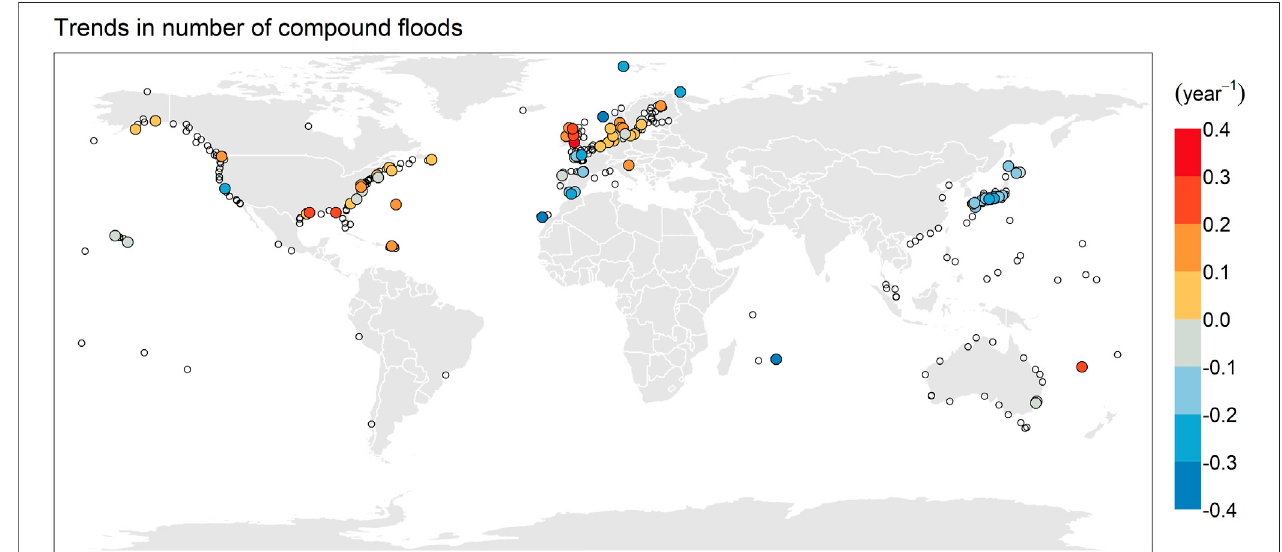
FIGURE 4 | Trends in the annual number of compound fl ood days. Compound fl ood days are the days with extreme precipitation and extreme storm surge exceeding the 90th percentile values. Open circles denote the trends are insigni fi cant ( α (cid:1) 0.1).